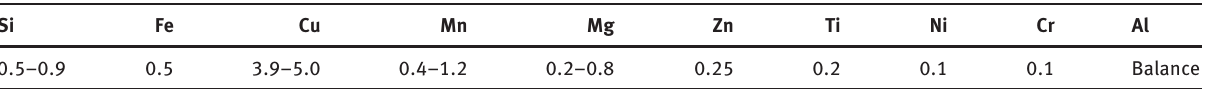
Table 2: Chemical composition of AA2014 alloy (wt.%).